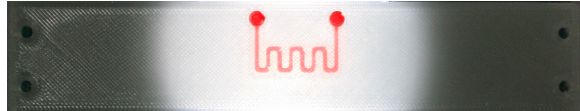
Figure 5. Sensor fabrication process: ( a ) Printing process of the 3D substrate with embedded microchannel; ( b ) Layout of the 3D printed substrate with embedded microfluidic channel; ( c ) Conductive top and bottom layers precisely cut with laser, and ( d ) Layout of the proposed sensors, top layer and bottom layer with mounted SMA connectors.